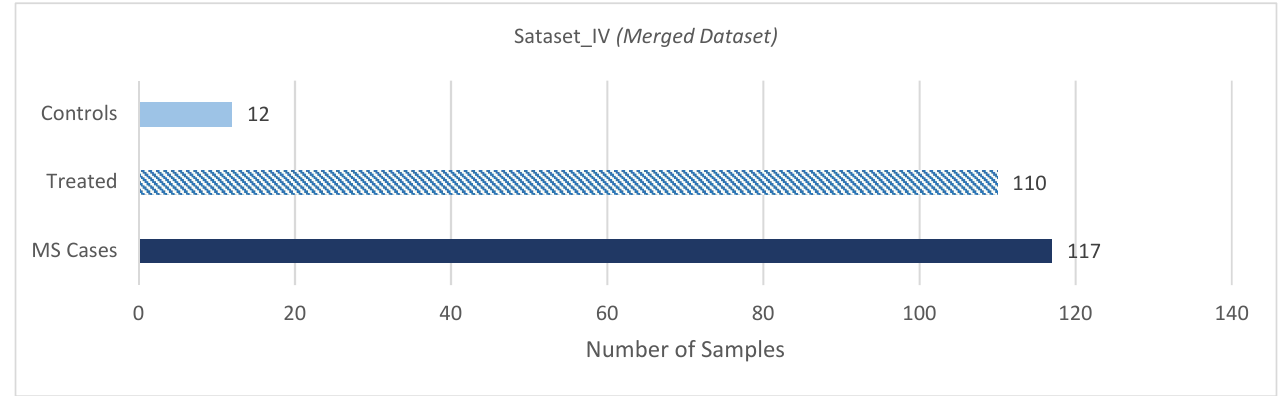
Figure 4. Sample distribution of Dataset_VI (by combining Dataset_II and Dataset_III), Dataset_VI consists of (a) 12 samples of controls; (b) 110 samples of treated MS patients; (c) 117 samples of untreated MS patients.